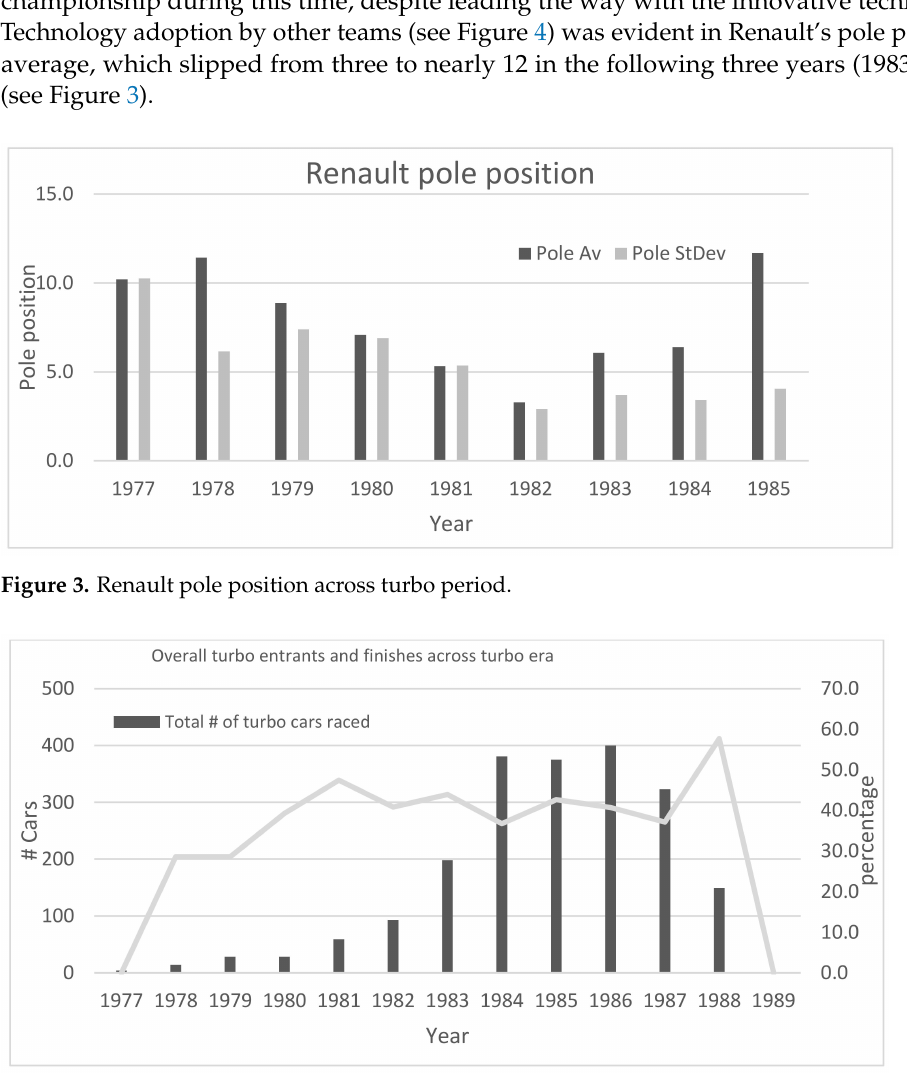
Figure 4. Turbo entrant starts and finishes across turbo